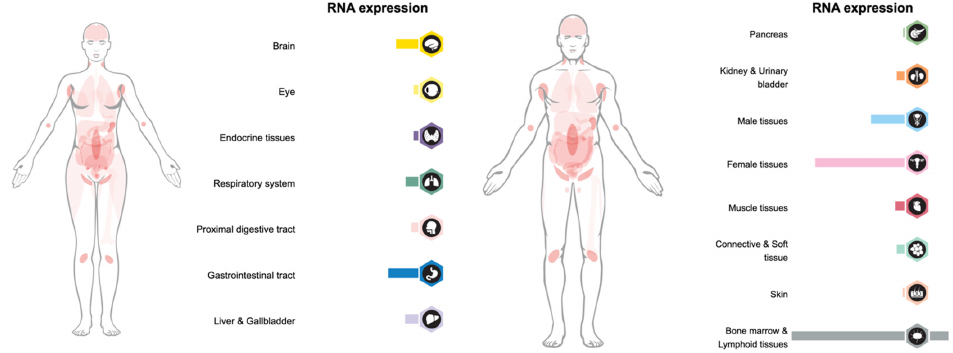
Figure 3. LAG-3 expression overview in tissues of the human body, visualization shows RNA-seq data generated by The Cancer Genome Atlas (TCGA) (Image credit: Human Protein Atlas www.proteinatlas.org. Image available at the following URL: v21.proteinatlas.org/ENSG00000089692-LAG3/tissue, accessed on 8 August